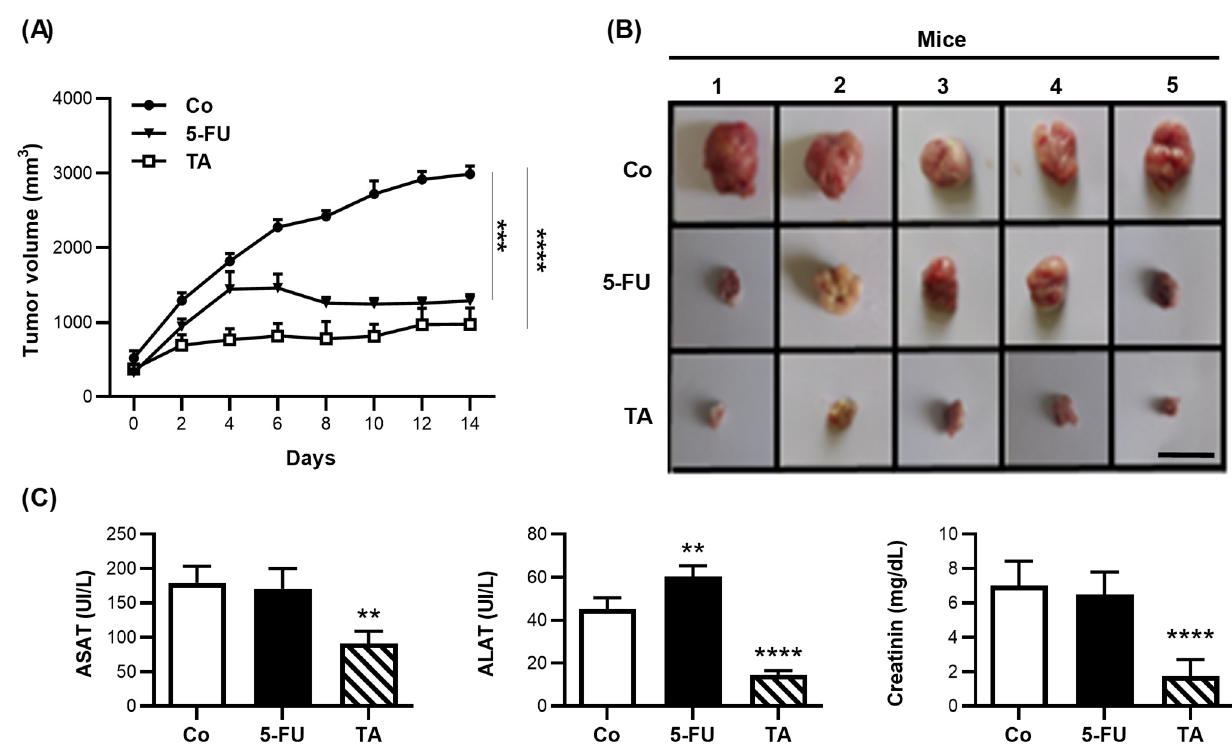
Figure 8. TA inhibits tumor growth without hepato- and nephrotoxicities in vivo. ( A ) One week after tumor cell injection, CT26 subcutaneous tumor-bearing BALB/c mice were treated (day 0 on the graph) with sterile saline solution (control group (Co, ), 5-FU (15 mg/kg, ), or TA (15 mg/kg, ), (n = 5 mice per group)), and the treatment was continuing at a rate of one injection every 2 days. The evolution of tumor volumes (mm 3 ) in time was determined. ( B ) Images of tumors harvested from the mice on day 14 (scale bar = 1 cm). ( C ) Measurement of serum aspartate transaminase (ASAT), alanine transaminase (ALT), and creatinine levels in Co, 5-FU-, or TA-treated mice. The data are ( A ) medians ± SEM or ( C ) means ± SD of 3 independent experiments (n = 3). Statistical significance was determined by one-way ANOVA, followed by Tukey’s test for multiple comparison tests, with ** p < 0.01, *** p < 0.001, and **** p < 0.0001, vs. the corresponding control group.